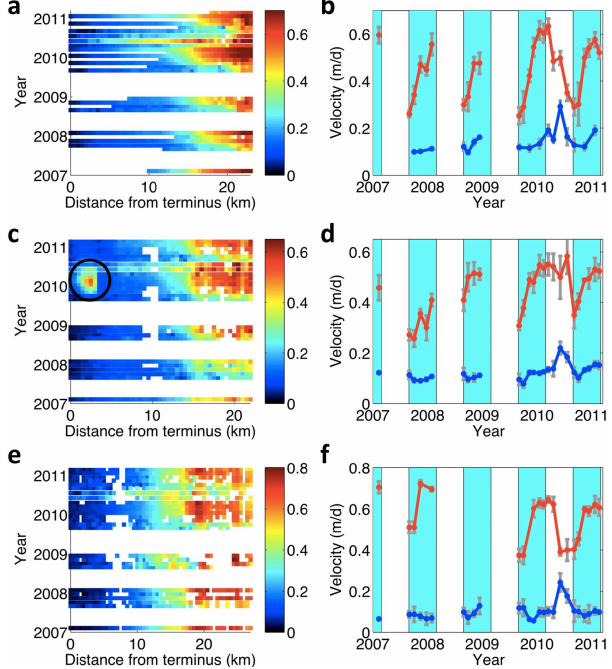
Figure 2. Left panels: Spatial and temporal changes in ice velocity along the flow lines of (a) Anderson, (c) Chitina, and (e) Walsh Glaciers. The profiles are plotted with 500m intervals along the flow lines shown in Fig. 1. Black circle indicates the speed-up signal caused by Ottawa Glacier ( a tributary of Chitina Glacier, and here is the confluence.). Right panels: Averaged time-series plots at two distinct sections derived from (a) , (c) , and (e) , respectively. Red line shows upper region ( b : 18–21km of, d : 18–21km, f : 21–24km) and blue line do lower region ( b : 5–8km, d : 5–8km, f : 4–7km). Cyan shades stand for winter season